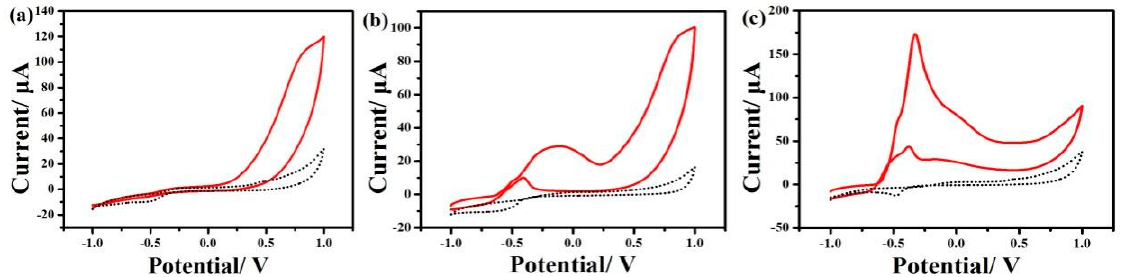
Figure 3. XRD patterns of COFs, Pd 2+ /COFs and Pd 2+ /COFs soaked in 0.1 M NaOH for 24 h.